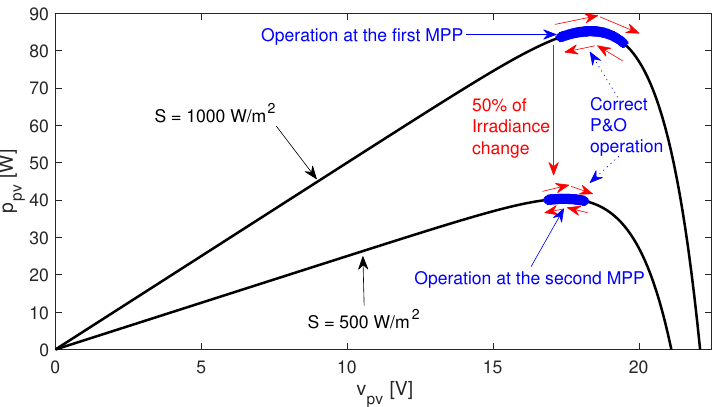
Figure 15. Power vs. voltage profile of the PV